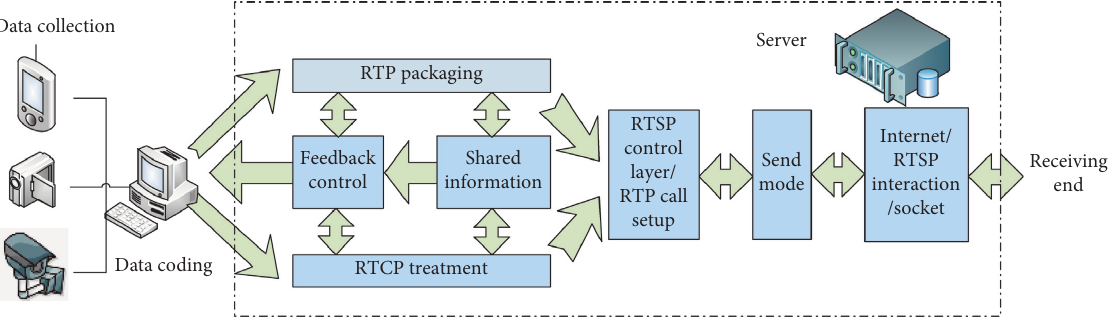
Figure 1: System basic framework.